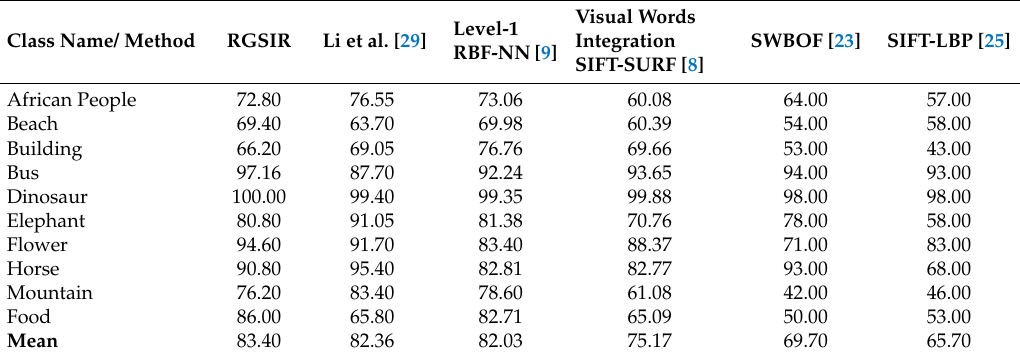
Table 1. Comparison of precision when using Corel-1K image